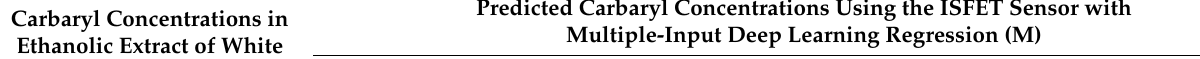
Table 2. The actual and predicted carbaryl concentrations using the ISFET sensor with the proposed multiple-input deep learning regression